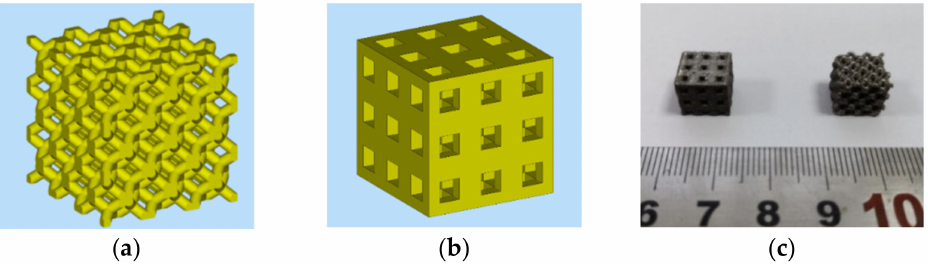
Figure 1. Model of the rhombic dodecahedron ( a ) and cubic ( b ) scaffolds. ( c ) The as-fabricated W scaffolds.